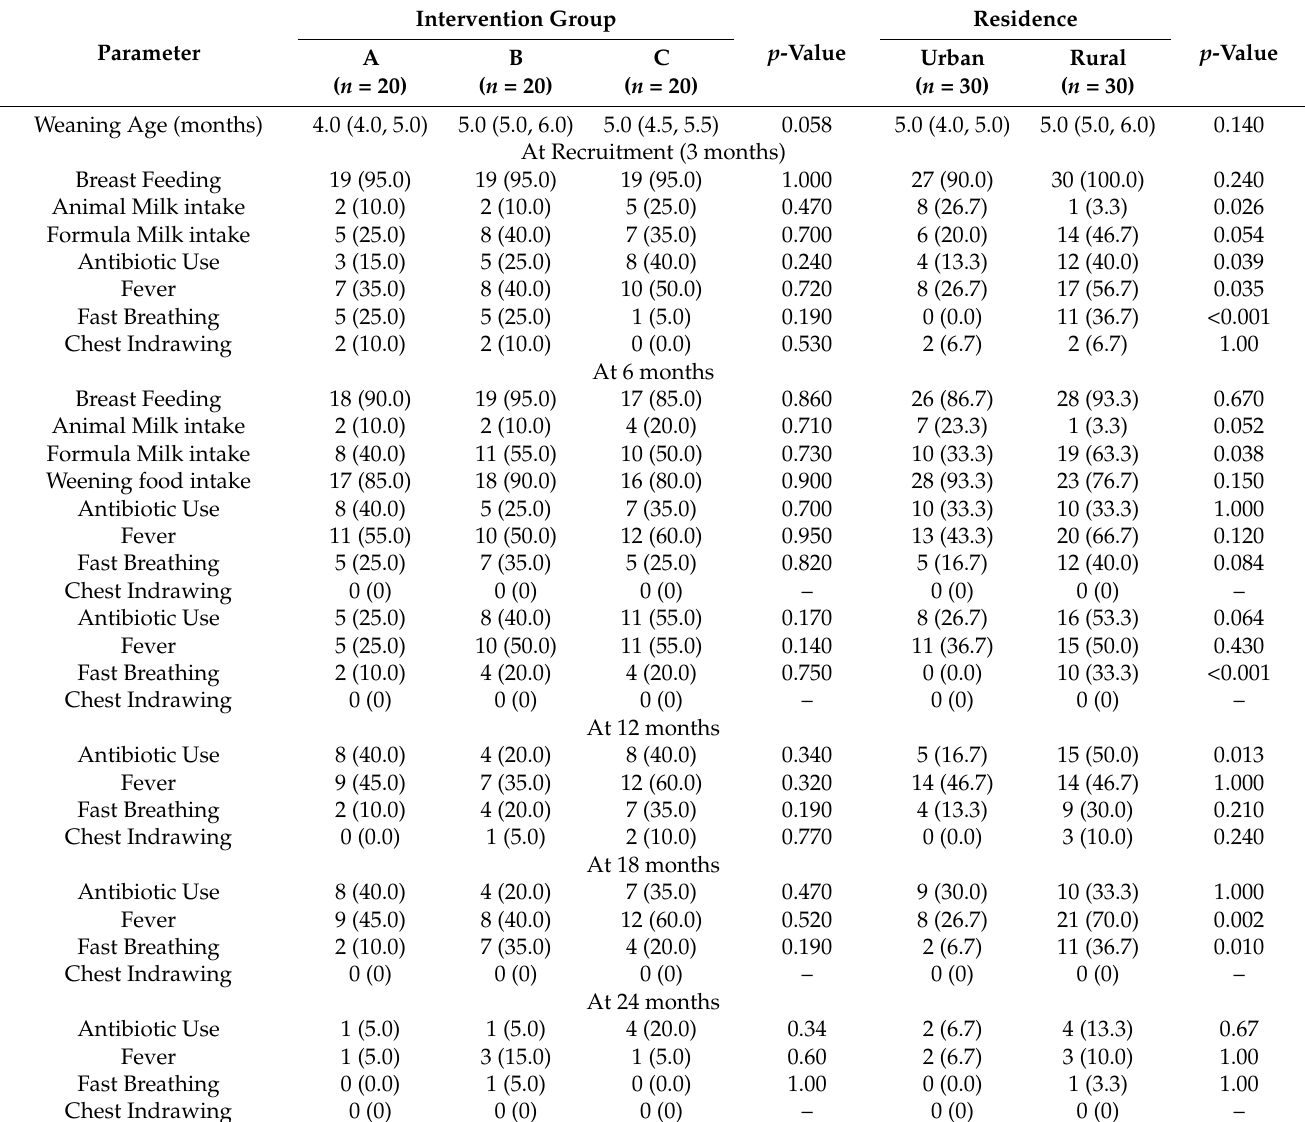
Table 2. Clinical data of children in urban and rural locations in each intervention arm at 3 monthly intervals. (summary statistics reflect the count and percentages in parenthesis for categorical